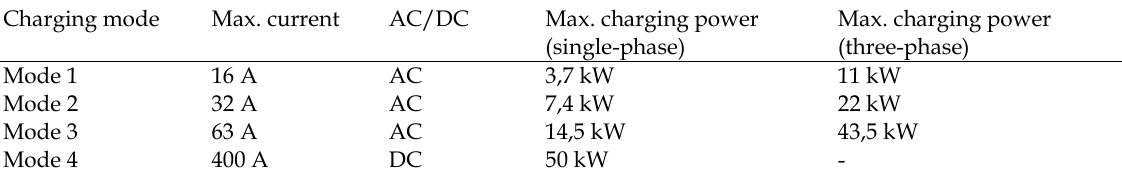
Overview of the IEC 61851 charging